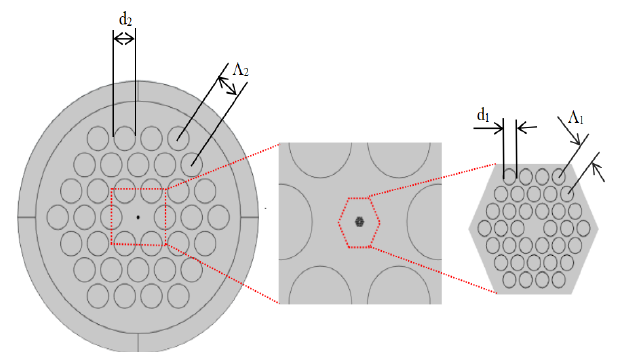
Figure 1: Designed PCF structure with inner hexagonal three ring having holes of diameter d 1 =0.8Ʌ 1 , where Ʌ 1 =0.05µm. The external rings have three rings of holes with diameter d 2 =0.8Ʌ 2 , where Ʌ 2